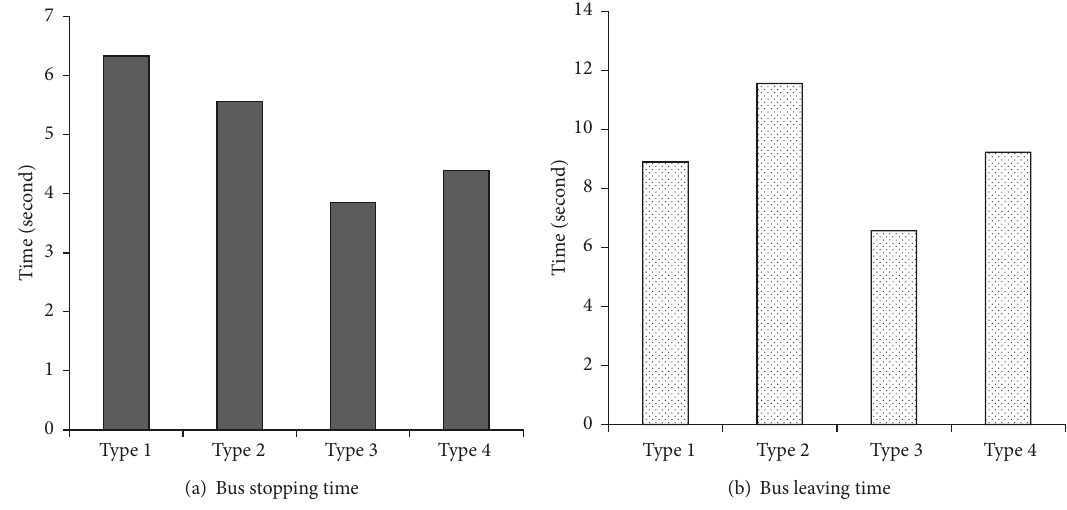
Figure 6: Bus operations at different types of bus stop areas